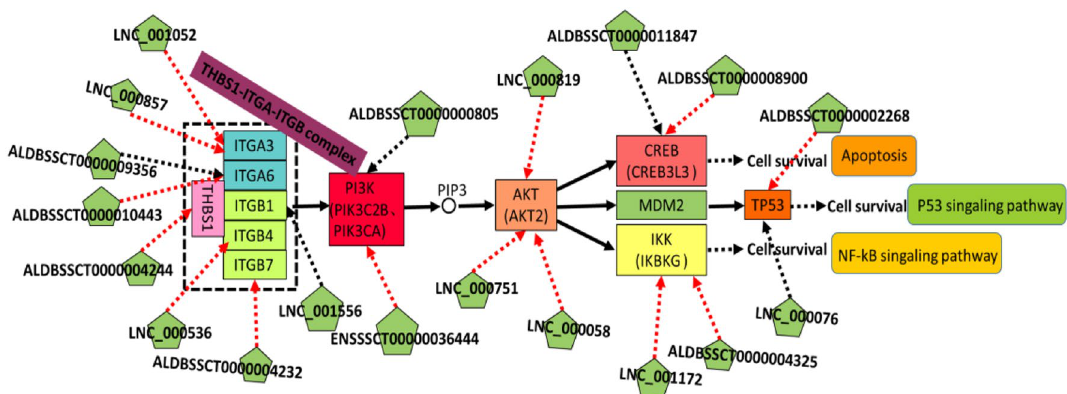
Figure 7. The regulatory network analysis and differentially expressed transcripts involved in PI3K-AKT signaling pathway in our study (RNA-Seq data). The red arrow represents positive correlation, the black arrow represents negative